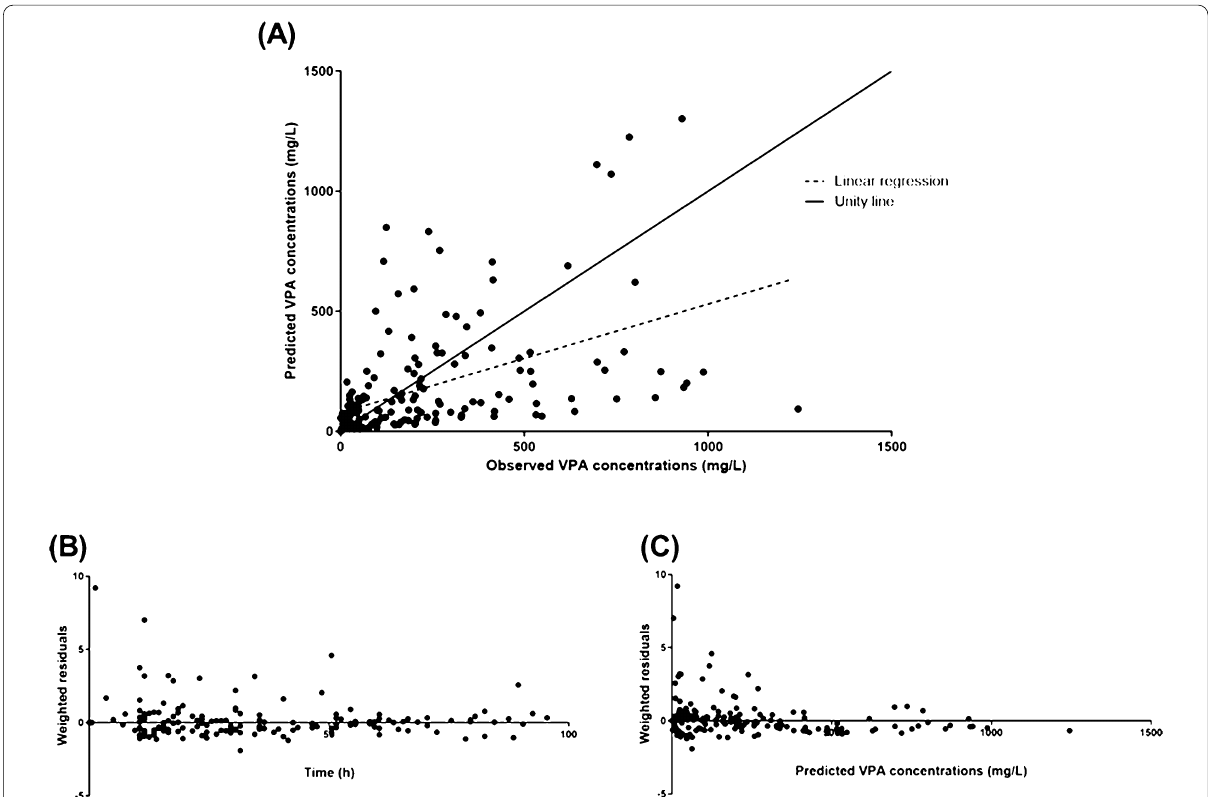
Fig. 1 Validation of the valproic acid (VPA) toxicokinetic model in nineteen poisoned patients with the predicted versus observed plasma VPA concentrations ( A ), the weighted residuals versus time ( B ) and the weighted residuals versus predicted plasma VPA concentrations ( C